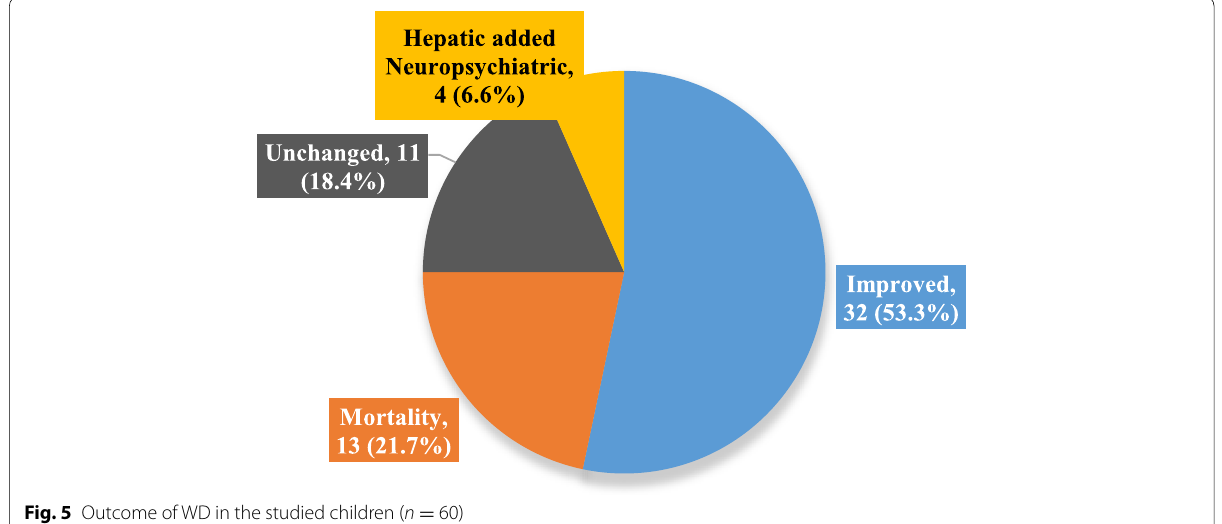
Fig. 5 Outcome of WD in the studied children ( n